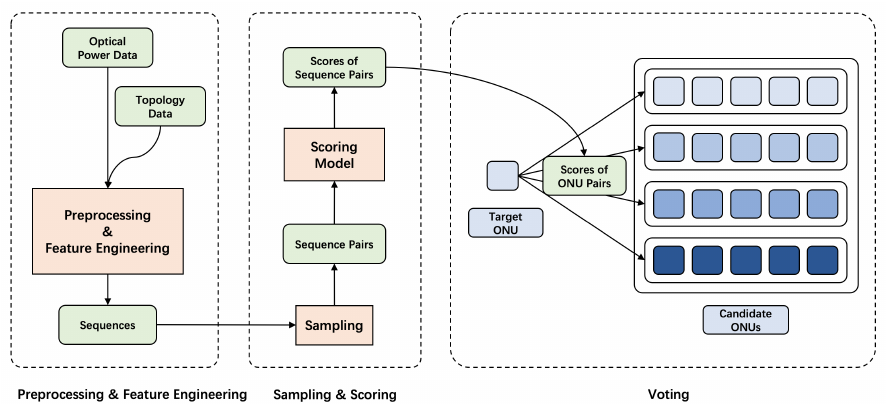
Figure 3. Structure of base solution. Optical power and topology data are firstly combined and preprocessed to get sequences. Then the scoring model gives the scores for the similarity of each sampled sequence pair. Using the scores, the voting algorithm determines the true label (secondary splitter) of the target